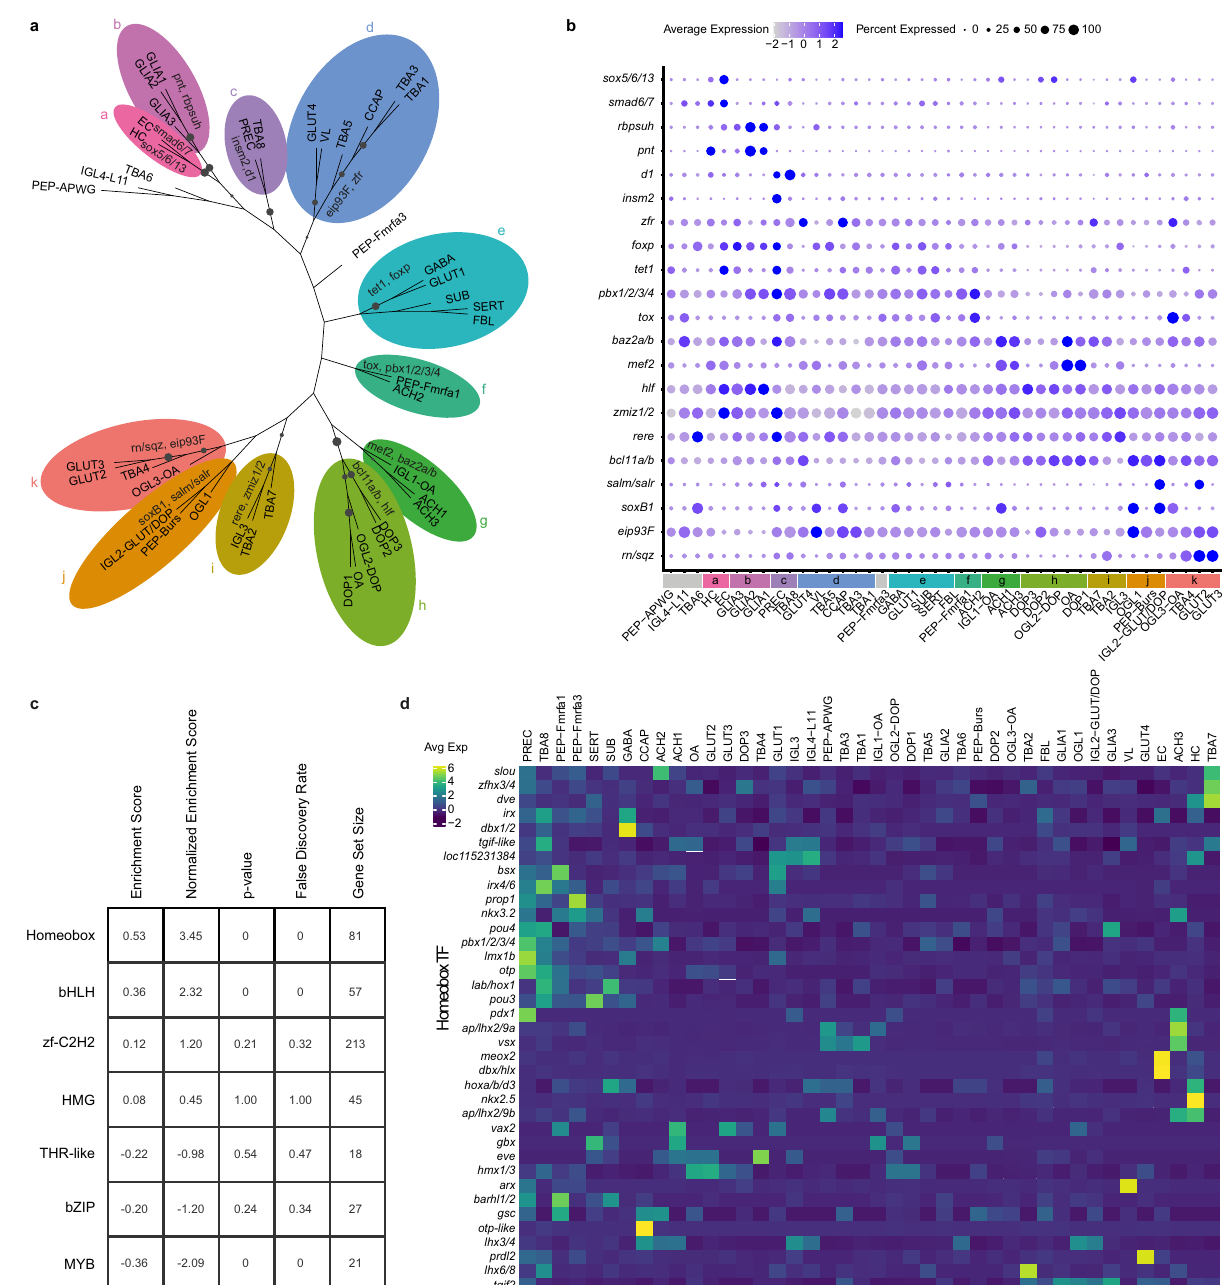
c Enrichment scores for the TF classes within the ranked list based on tau. d Heatmap of highly variable Homeobox transcription factors, averaged per cell type and